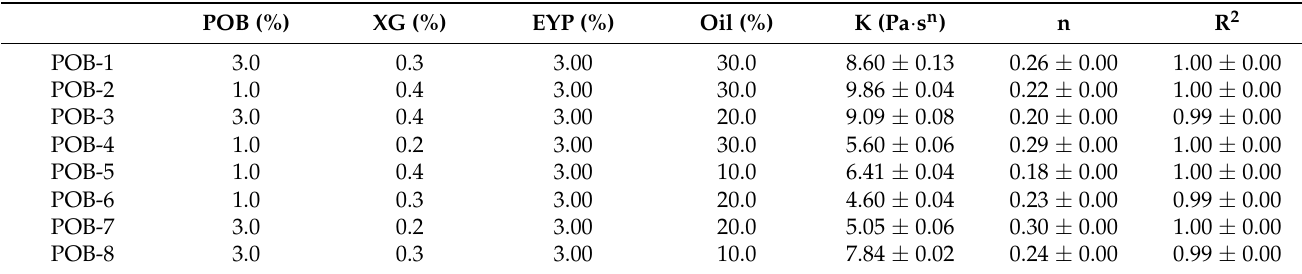
Table 1. Steady shear power-law parameters of the salad dressing samples contained pumpkin seed by-products with ingredient